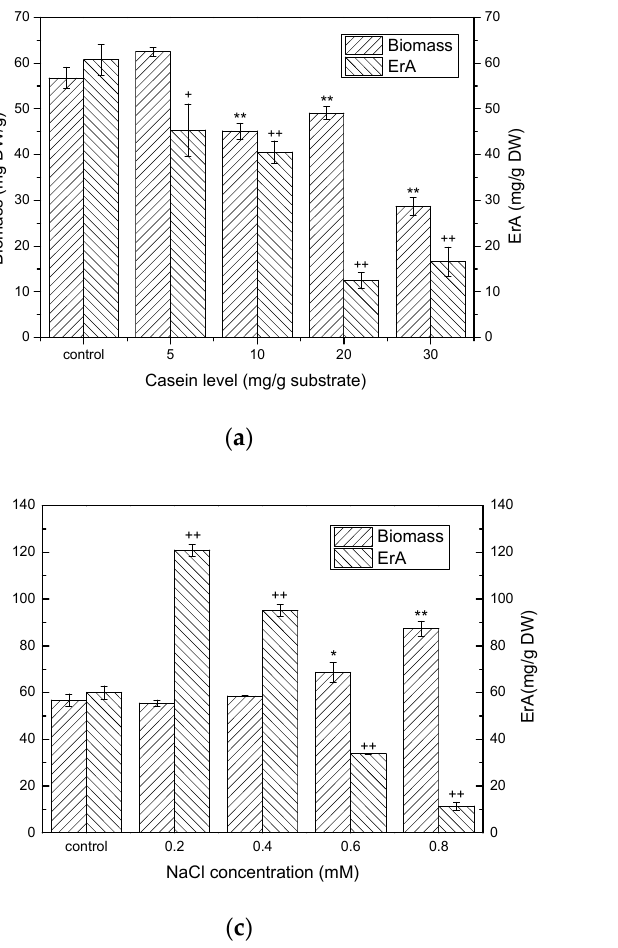
Figure 6. Effect of ( a ) casein, ( b ) tryptone, ( c ) NaCl, and ( d ) ZnSO 4 ·7H 2 O addition on mycelial growth and ErA production. *, ** indicate biomass significant difference with control at p < 0.05 and p < 0.01, respectively. +, ++ indicate ErA significant difference with control at p < 0.05 and p < 0.01, respectively.